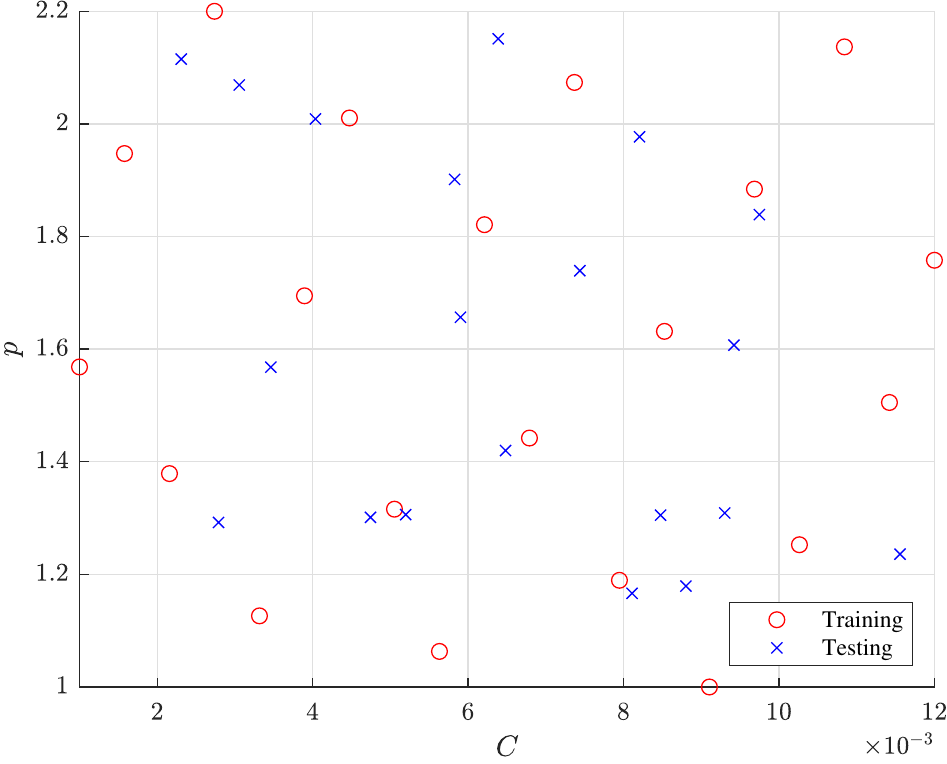
Figure 8. Sampled constitutive parameters in the training and testing data